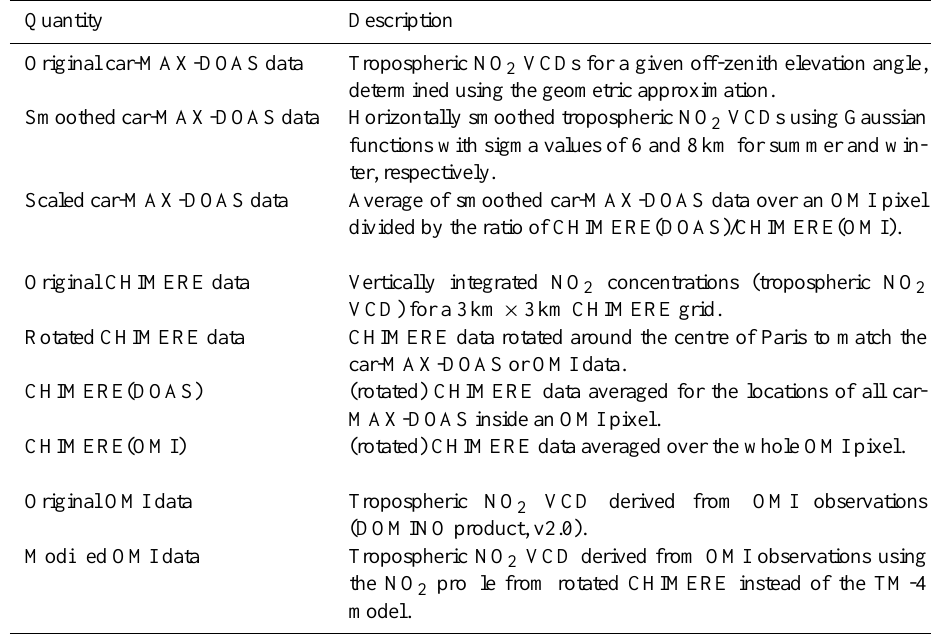
Table 1. Overview on the different quantities used in this